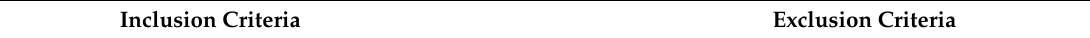
Table 2. Eligibility